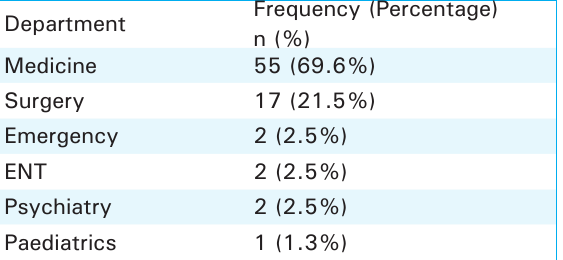
Table 1. Patient’s referral according to the speciality.